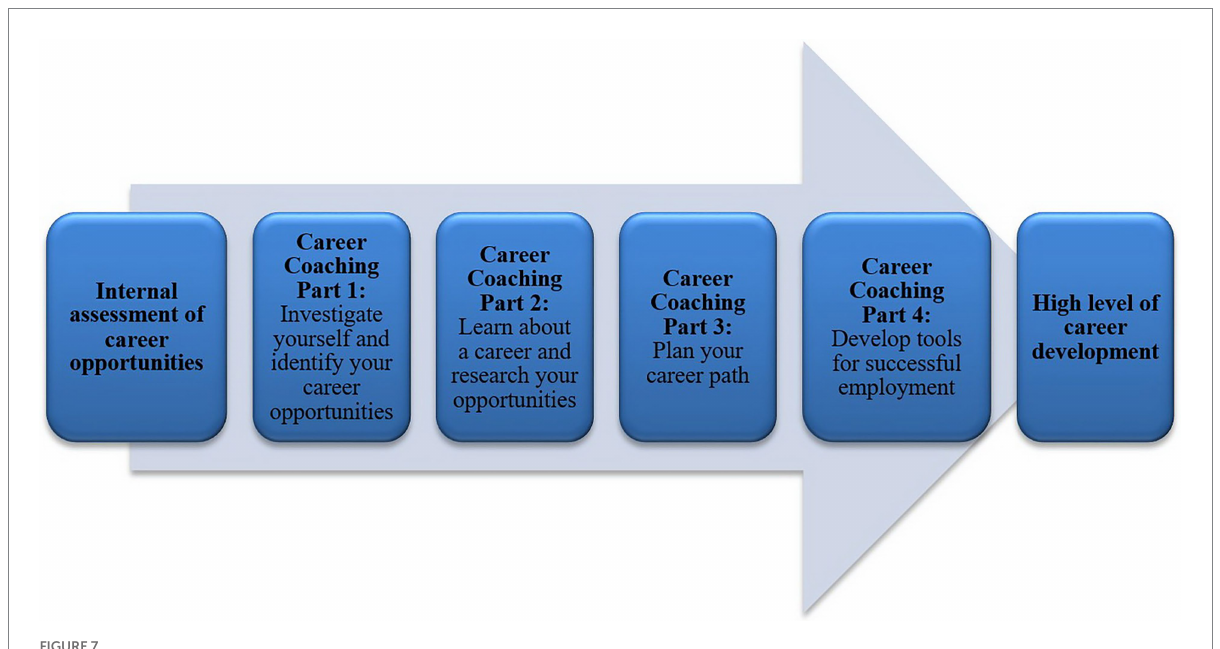
FIGURE 7 The career coaching